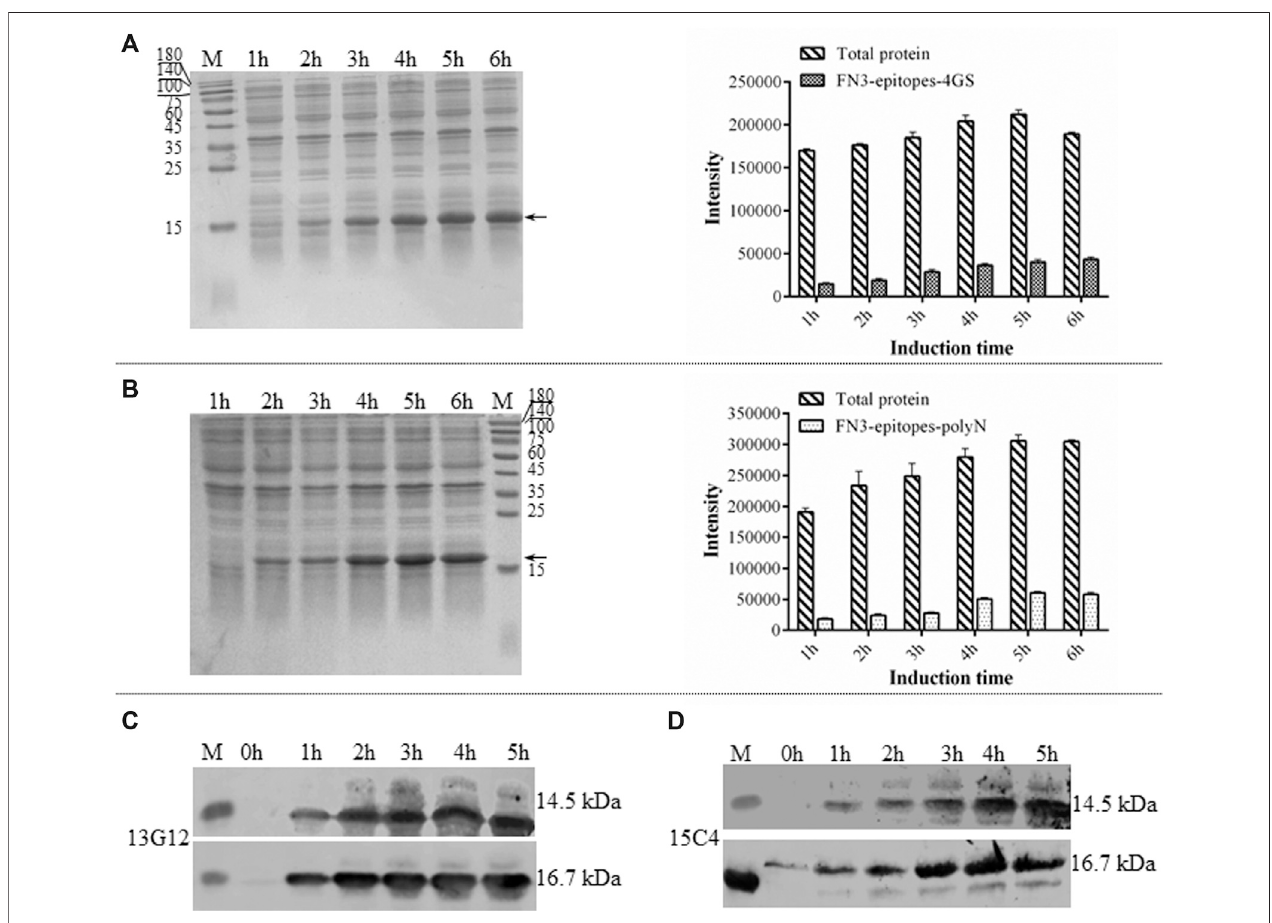
FIGURE 2 | The expression of recombinant FN3-epitopes in E. coli . ( A, B ) SDS-PAGE analysis of the expression of protein FN3-epitopes-4GS (A) and FN3- epitopes-polyN(B)afterinductionfor1 – 6 h.ArrowindicatesthetargetproteinFN3-epitopes-4GS(14.5 kDa)orFN3-epitopes-polyN(16.7 kDa),andeachsampleofthe total bacterial extract loadedon the gels isfrom 1ODunit ofcells. Thesignal intensity calculated from SDS-PAGEimages in part Aand B,respectively. Data correspond to averages of three independent experiments. Error bars represent standard deviations. ( C, D ) Western blot analysis of the expression of FN3-epitopes-4GS (upper panel) and FN3-epitopes-polyN (lower panel) at the indicated induction time points using HRP-conjugated mouse anti-human NT-proBNP 4NT1C-13G12 (C) or mouse anti-human NT-proBNP 4NT1-15C4(D), speci fi c to the amino acid residues 13 – 27 and 61 – 76 of NT-proBNP, respectively. M: molecular